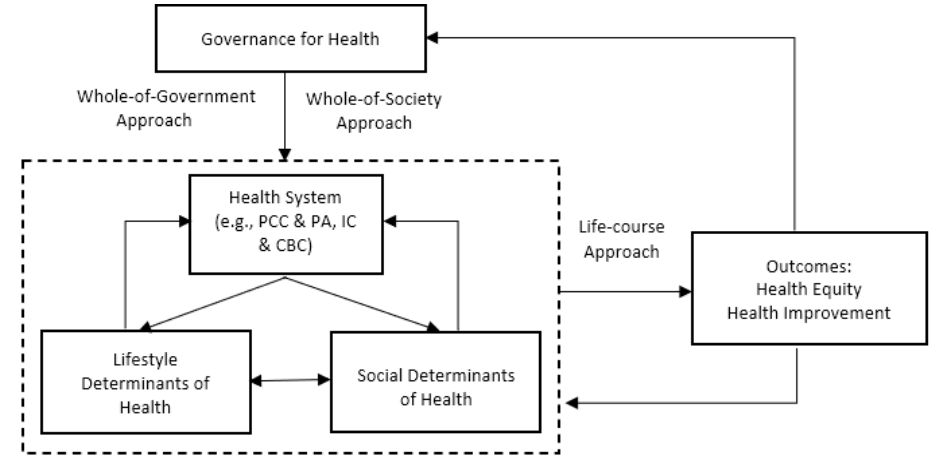
Figure 1. A proposed conceptual framework on active health